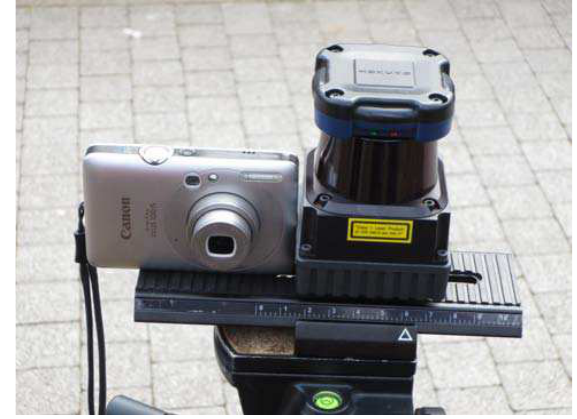
Figure 1. The two sensor devices utilized for the experiments: digital camera (Canon Digital IXUS 100 IS) and lightweight laserscanner (Hokuyo UTM-30LX-EW).